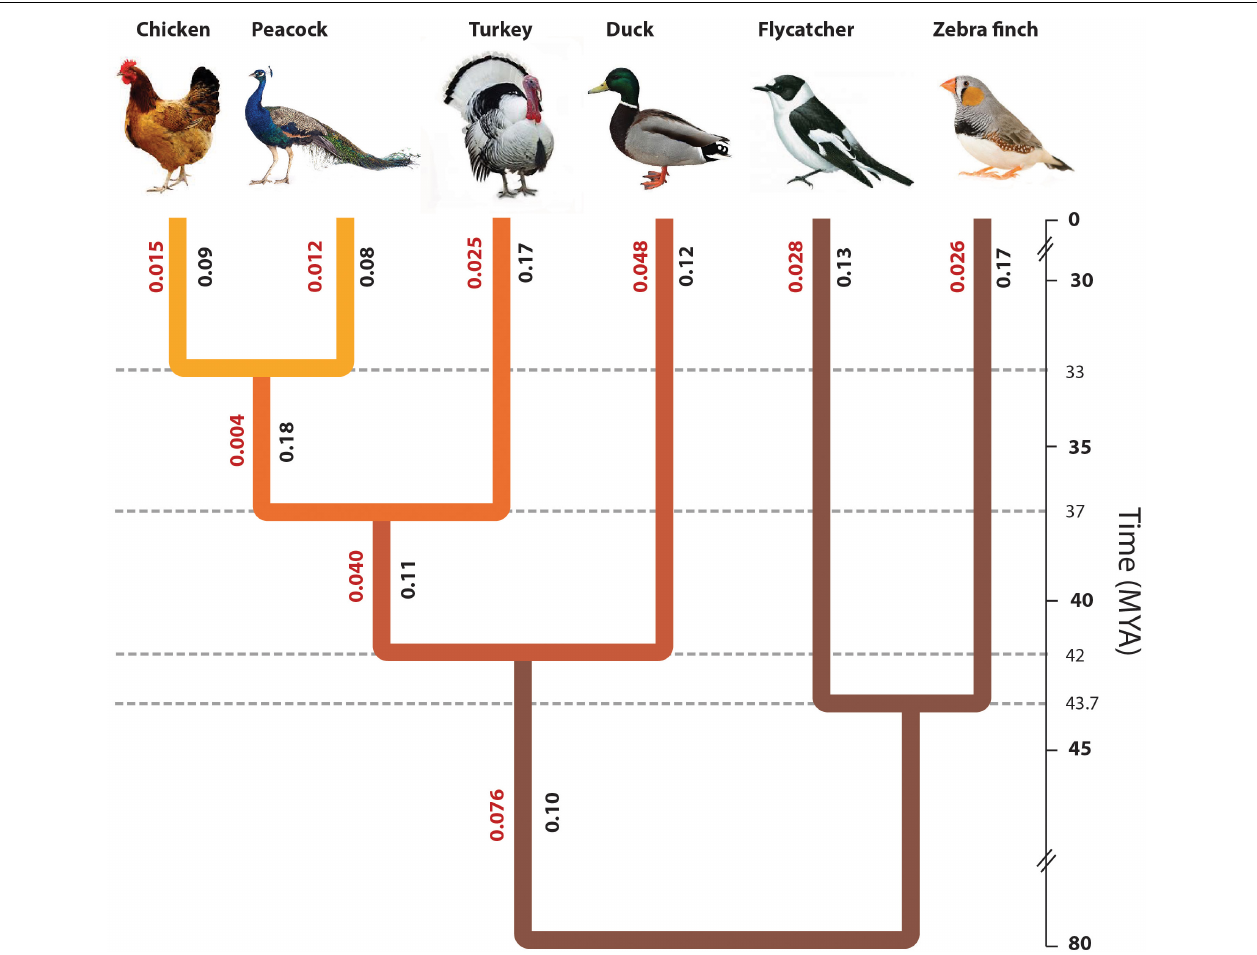
FIGURE 2 | Phylogenetic position of peacock with respect to other bird genomes. The phylogenetic tree constructed from the concatenated alignments of the orthologous genes across all six species. The divergence time of different bird species was determined using the TimeTree database (Hedges et al., 2006), which is based on the published reports of molecular and fossil data. The origin of turkey was estimated to be ∼ 37.2 MYA, whereas the origin of peacock and chicken was estimated to be ∼ 32.9 MYA. The original phylogeny from the data had a polytomy due to which the split point between zebra finch and flycatcher could not be identified. However, for the sake of correct visual interpretation the divergence point between flycatcher and zebra finch ( ∼ 44 MYA) was identified using the TimeTree database. The values mentioned in Red are the branch length values and the values mentioned in Black are the phylogenetically corrected branch-specific ω or dN/dS